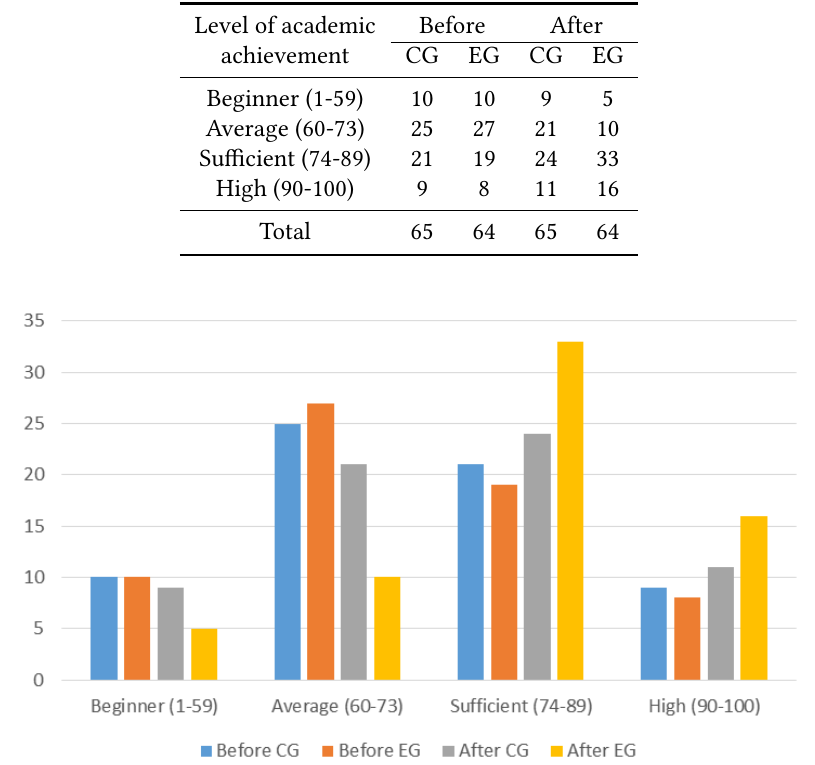
Figure 11: Comparative distribution of students in CG and EG according to the level of academic achieve- ments in the fundamentals of programming at the beginning and end of the pedagogical